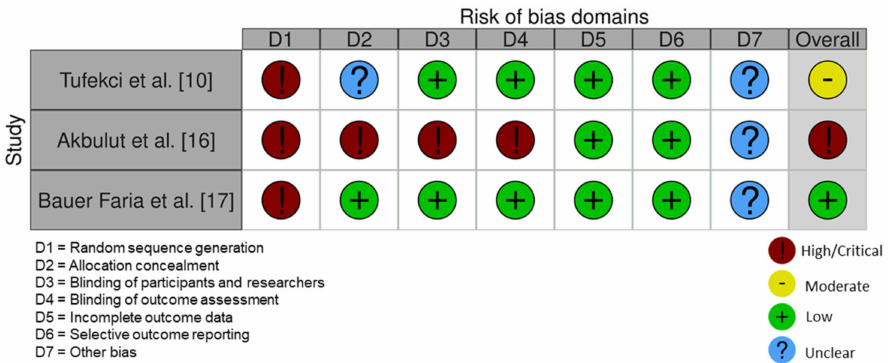
Figure 3. Risk of bias of the included non-randomized controlled